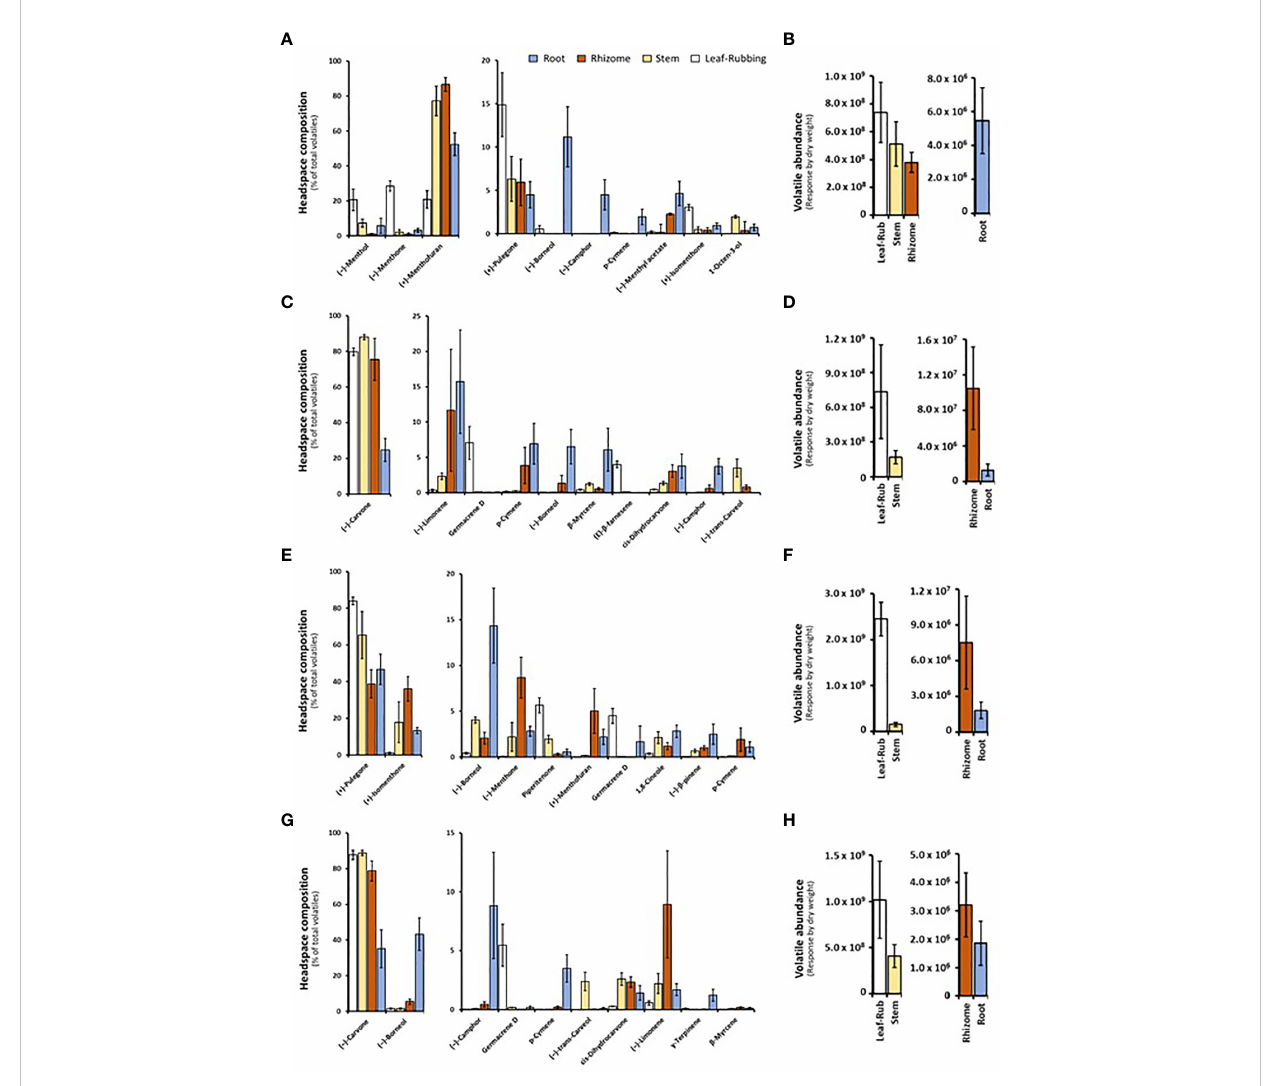
FIGURE 2 Monoterpenoid volatiles released by several organs of greenhouse-grown mint species as determined by SPME – GC – MS analysis (columns represent means of 6 biological replicates, with bars showing the standard error of the mean). (A) peppermint; (C) spearmint; (E) M. longifolia CMEN 585; and (G) M. longifolia CMEN 584. The volatile abundance is shown in (B) (peppermint), (D) (spearmint), (F) ( M. longifolia CMEN 585), and (H) ( M. longifolia CMEN 584). The color code of columns is as follows: white, leaves; yellow, stems; orange, rhizomes; and blue,